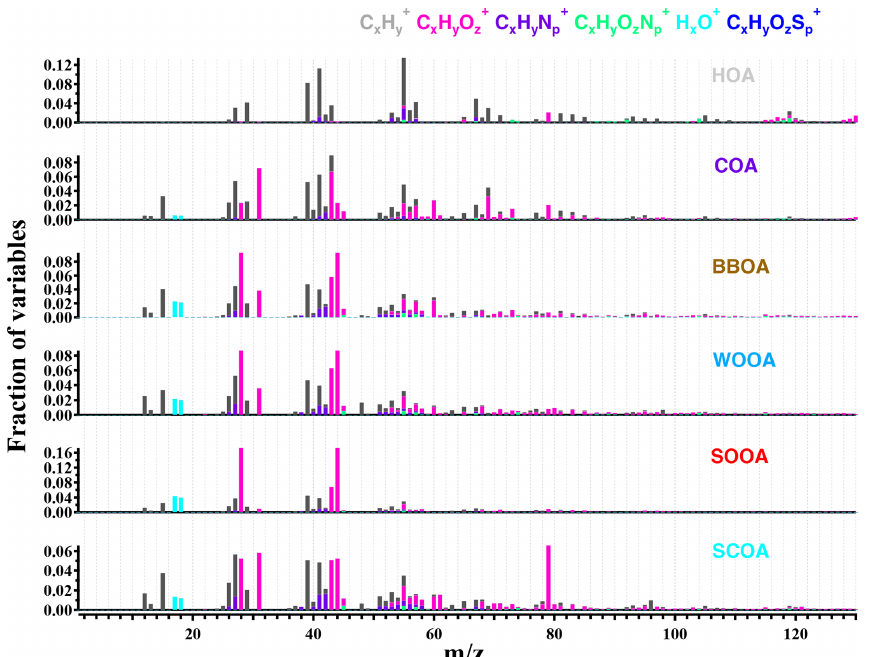
Figure 1. Factor profiles for the six-factor solution for AMS results with HOA AMS and COA AMS constrained by a = 0 . 1. The total signal of each factor is normalized to unity, and the y axis presents the fractional contributions of the variables to the total signal of the fac- tor (HOA AMS : hydrocarbon OA: COA AMS : cooking-related OA; BBOA AMS : biomass burning OA; WOOA AMS : winter oxygenated OA; SOOA AMS : summer oxygenated OA; SCOA AMS , sulfur-containing oxygenated